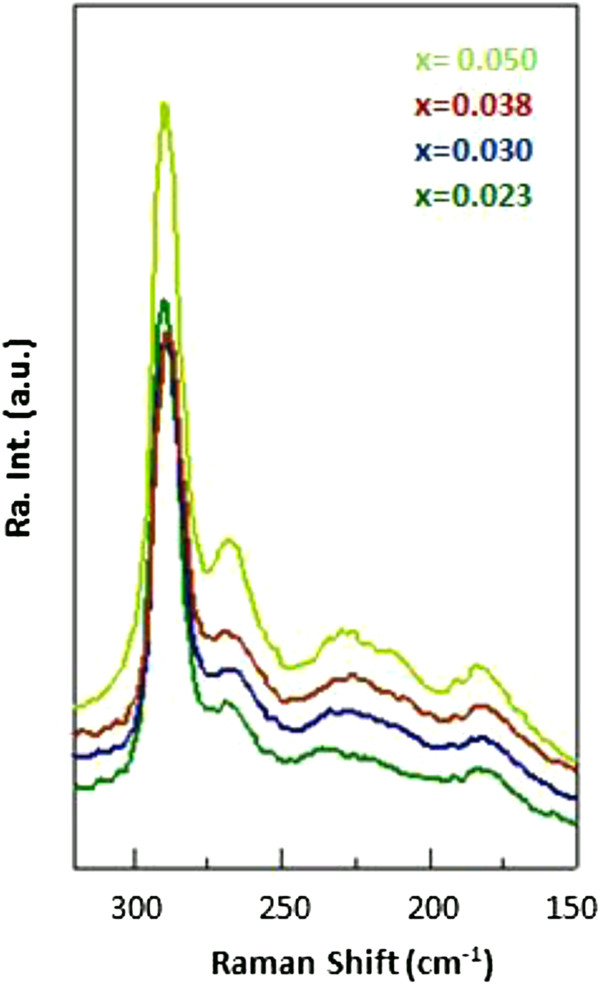
Raman spectra of GaAs1 - xBix(x = 5.0%, 3.8%, 3.0%, and 2.3%).